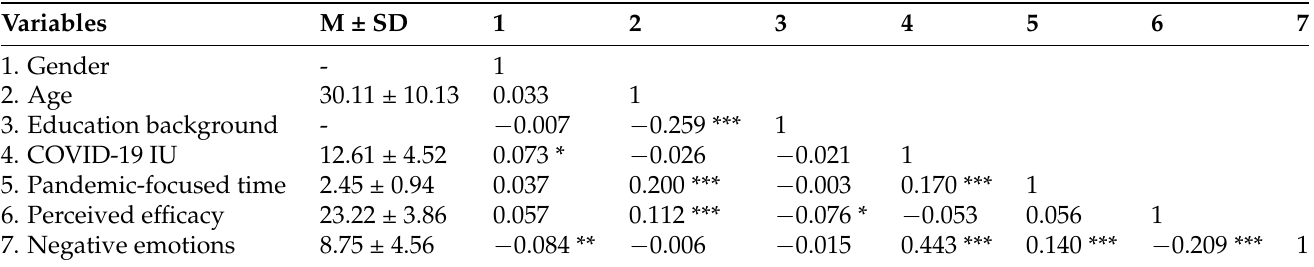
Table 2. Descriptive statistics and correlations among variables. N =